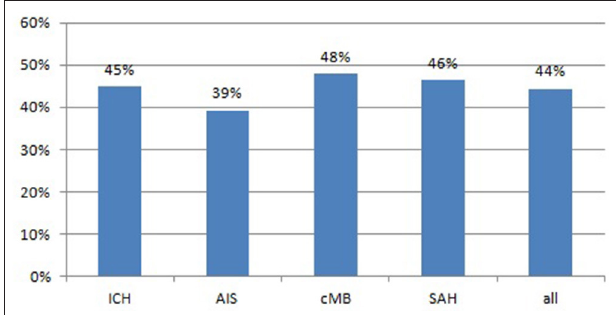
FIGURE 6 | Percentage of positive risk factors per